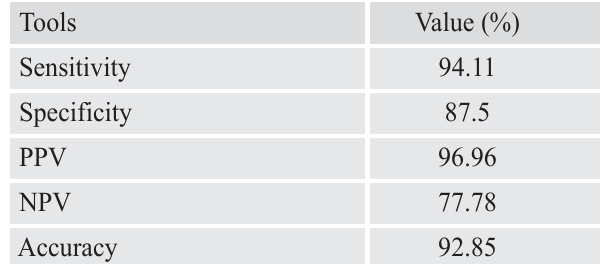
Fig 3. Photomicrograph of lymphocyte-predominant